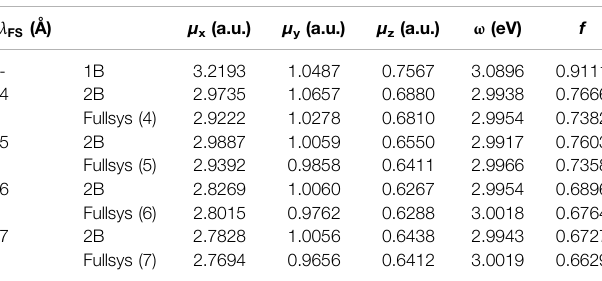
TABLE 1 | Transition electric dipole moment (TEDM) calculated by EE-GMFCC and corresponding full-system calculations at the TD-HF/6-31G* level for different model systems with different distance thresholds λ FS . μ x , μ y , and μ z are the calculated TEDM values in x , y , and z directions, respectively. ω and f are the excitation energy and the corresponding oscillator strength, respectively. Here, the λ 2 B employed in EE-GMFCC calculations for different model system was set to the same value as the λ FS